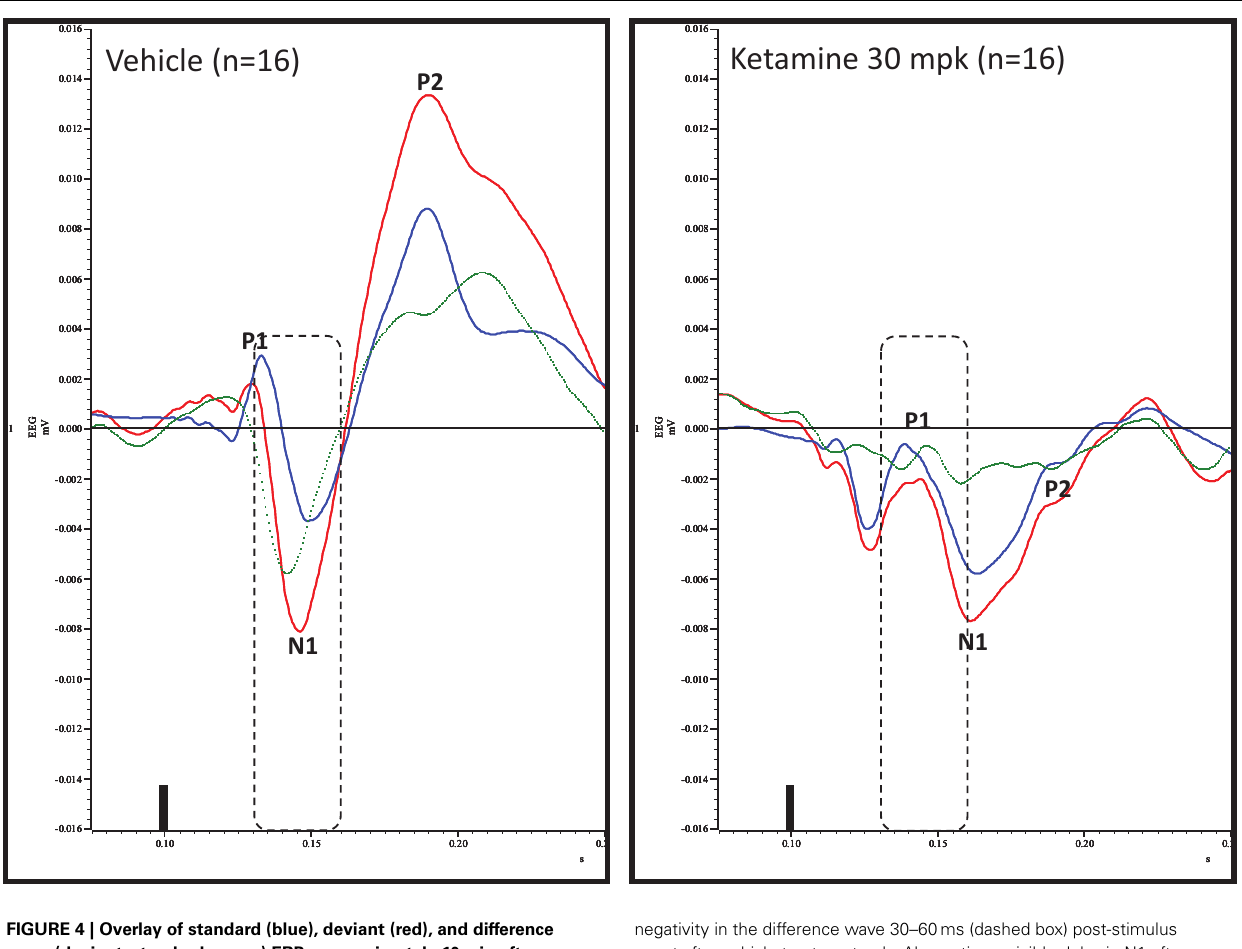
FIGURE 4 | Overlay of standard (blue), deviant (red), and difference wave (deviant–standard; green) ERPs approximately 10min after vehicle or ketamine treatment is shown . Notice a well-defined